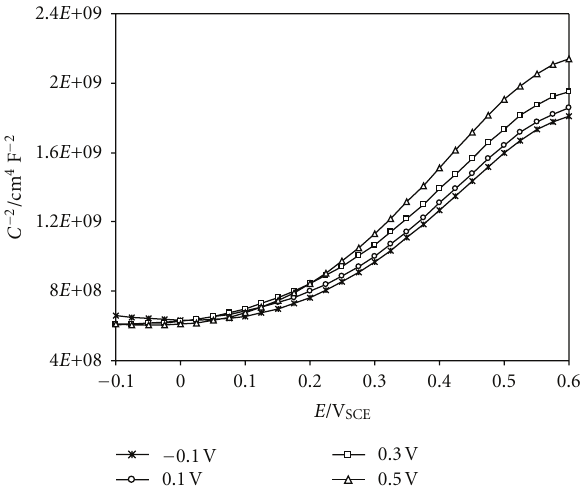
Figure 4: Mott-Schottky curves for passive films formed on 316 at di ff erent film formation potentials for 1 h in 0.05M H 2 SO 4